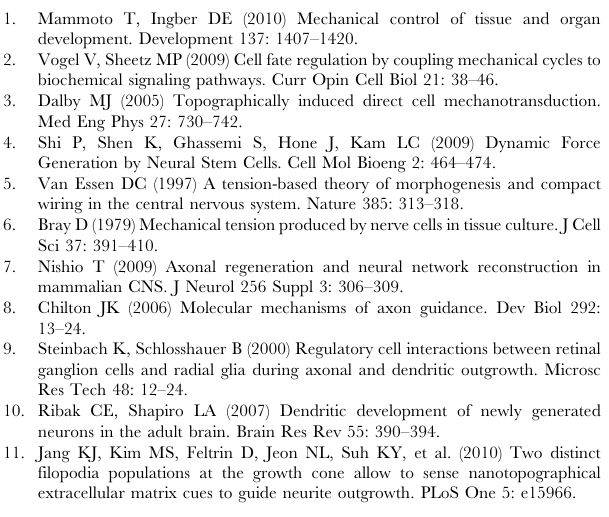
drawn in red and points down and